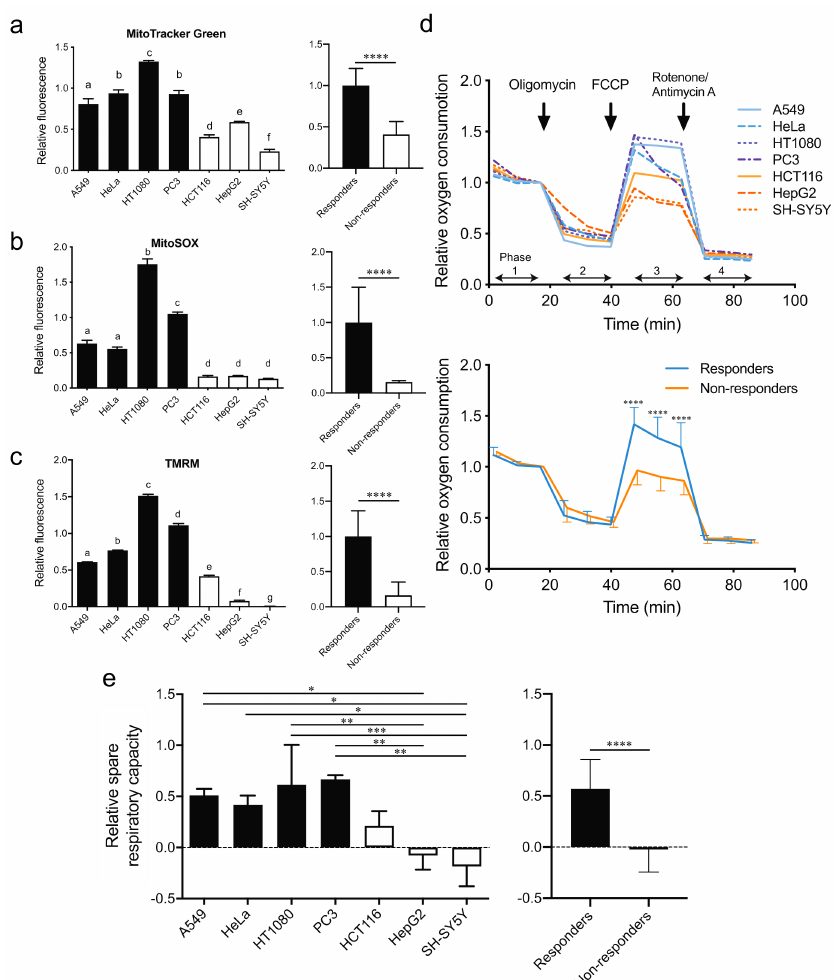
Figure 4. Mitochondrial functions of seven cell lines. Flow cytometric analyses of relative flu- orescence signals for MitoTracker Green representing the amount of mitochondria ( a ), MitoSOX representing the amount of mitochondrial superoxide ( b ), and TMRM representing the mitochondrial membrane potential ( c ). Mean and SD are indicated ( n = 3 culture dishes). Single letter labels indicate p < 0.05 by one-way ANOVA followed by Tukey’s multiple comparison test. Values in